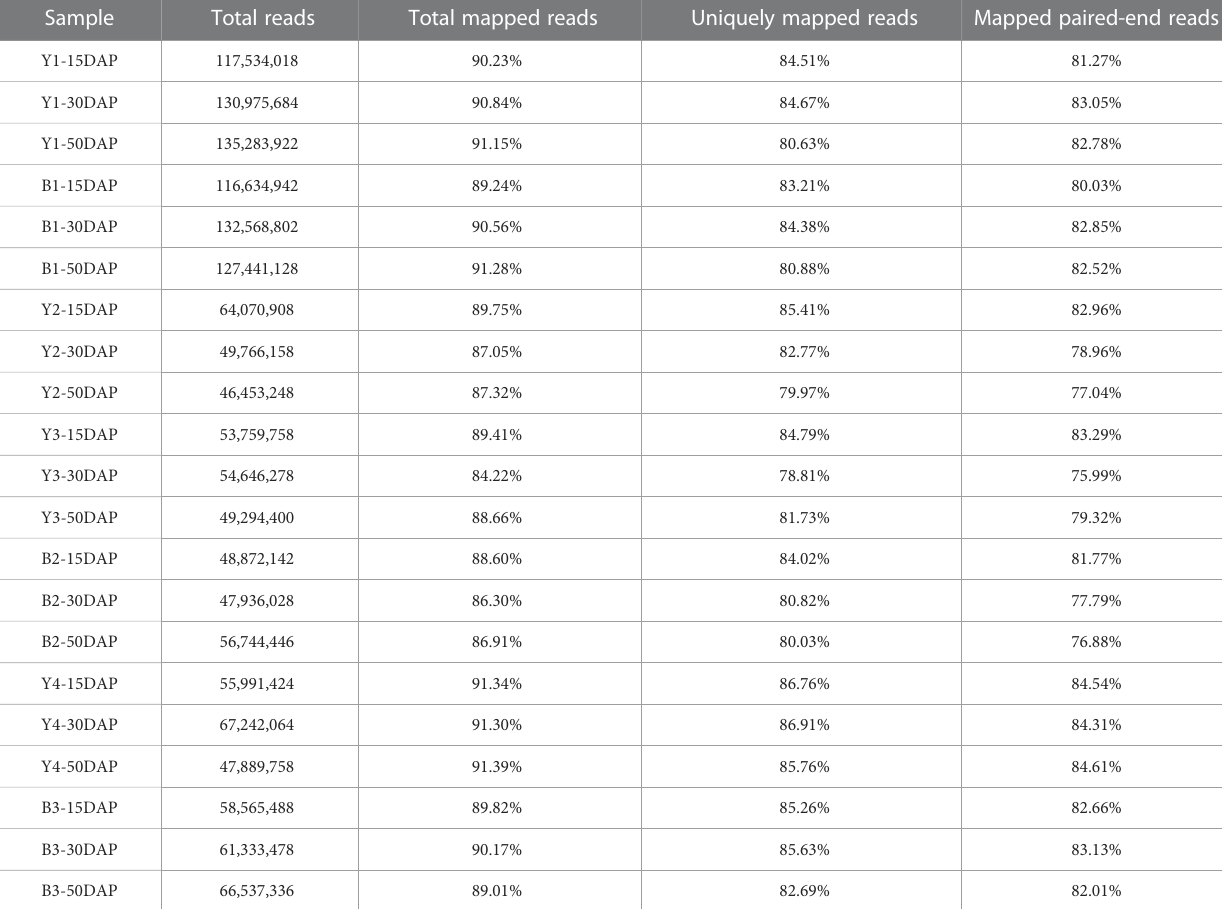
TABLE 1 Summary statistics of RNA-Seq results during seed development in B. napus .